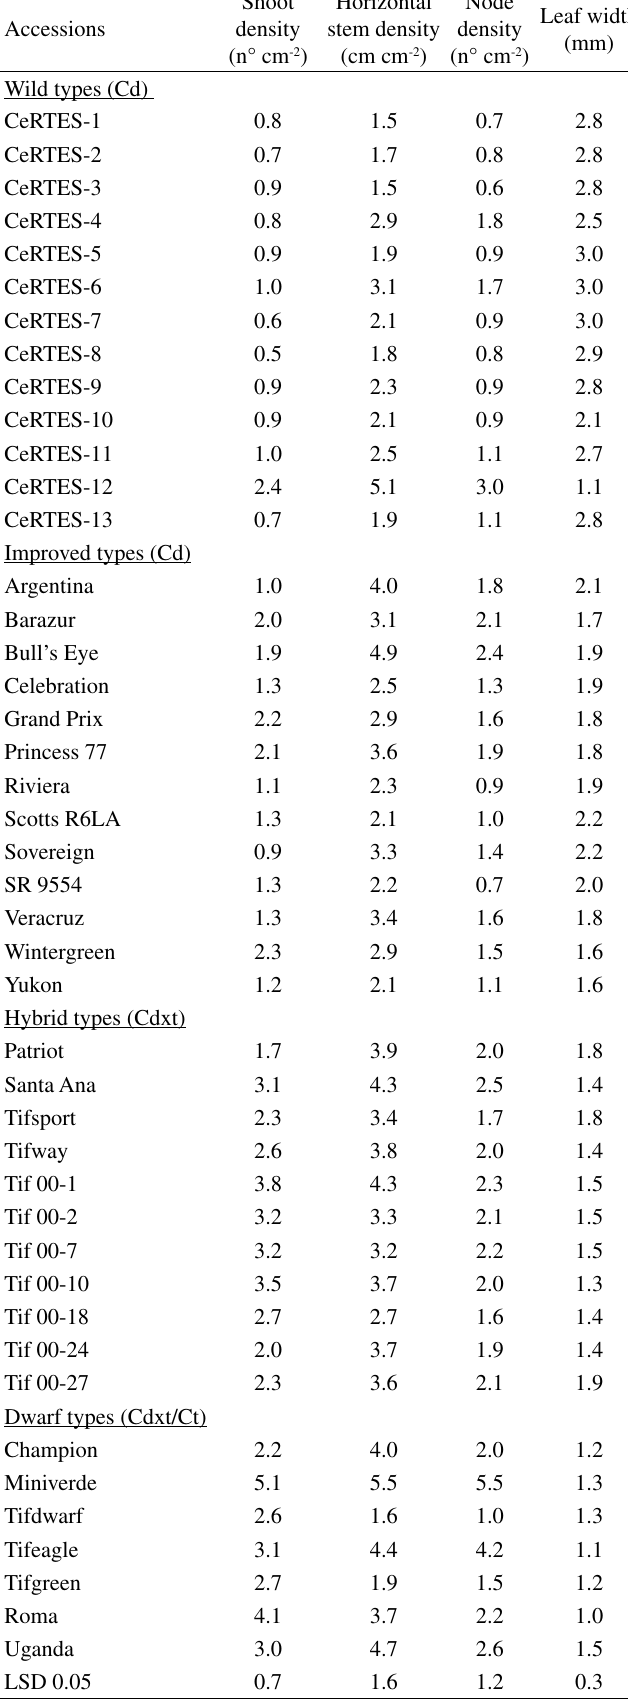
Table 3 - Bermudagrass [ Cynodon (L.) Rich.] accessions. Shoot density, horizontal stem density, node density and leaf width.